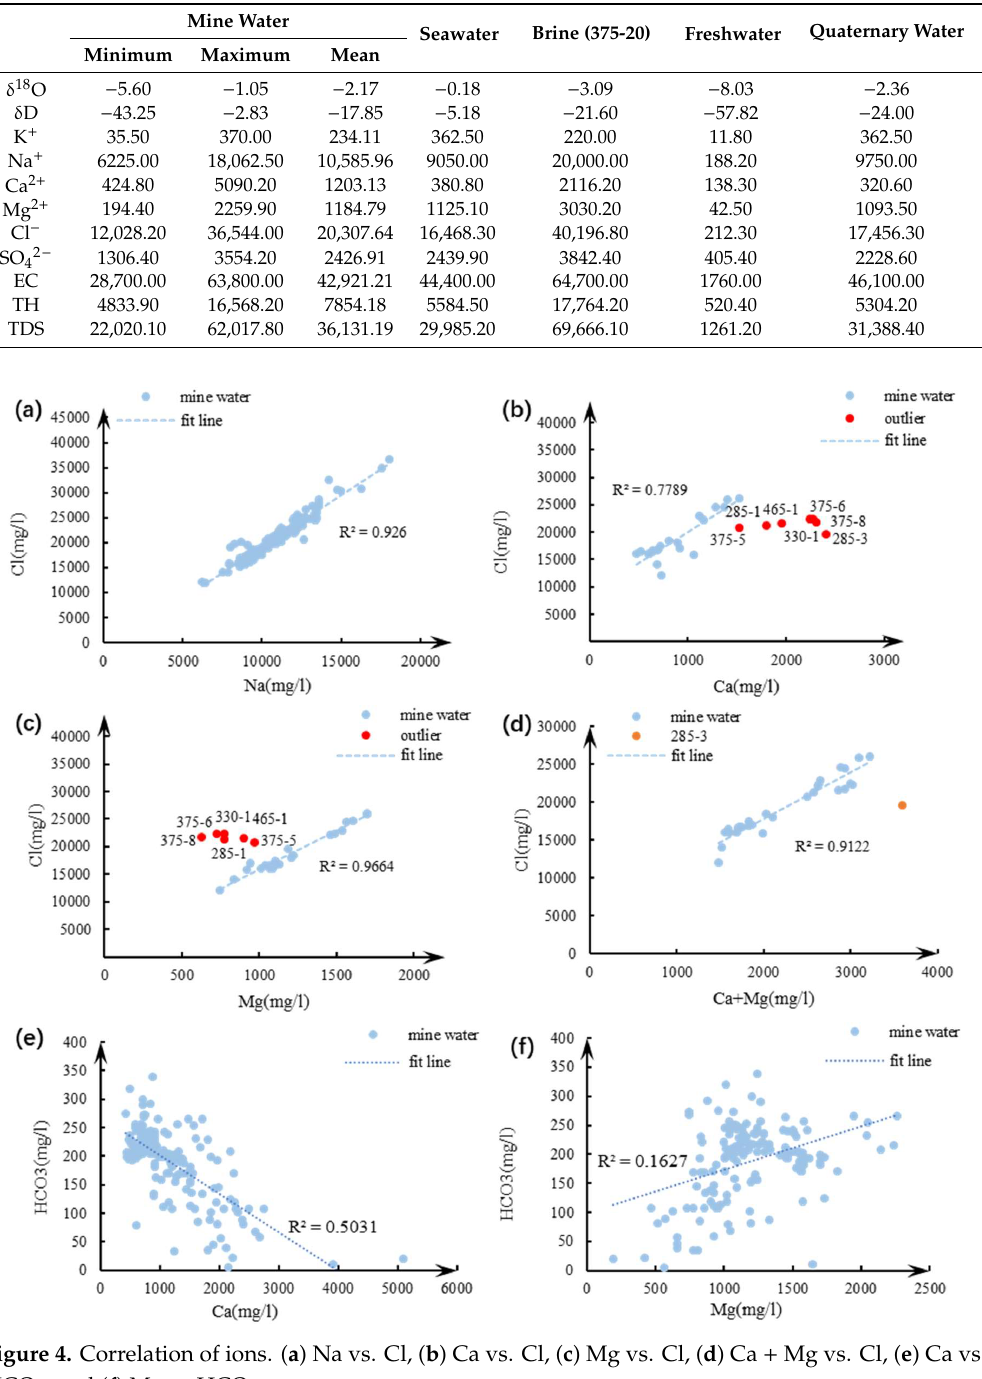
Table 1. The analyses results of mine water and four potential water sources, including isotope (% (cid:24) ), concentrations of ions (mg / L), EC (S / cm), TDS (mg / L), and TH (mg / L).